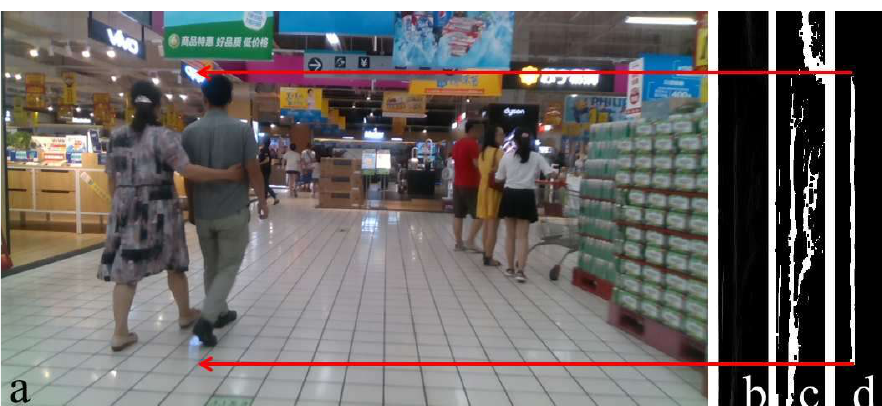
Figure 7. Obstacle’s height calculation using the proposed restricted v-depth map. ( a ) The same snapshot from Figure 4a. ( b ) Corresponding v-depth map. ( c ) Corresponding thresholded v-depth map. ( d ) Corresponding proposed thresholded restricted v-depth map.